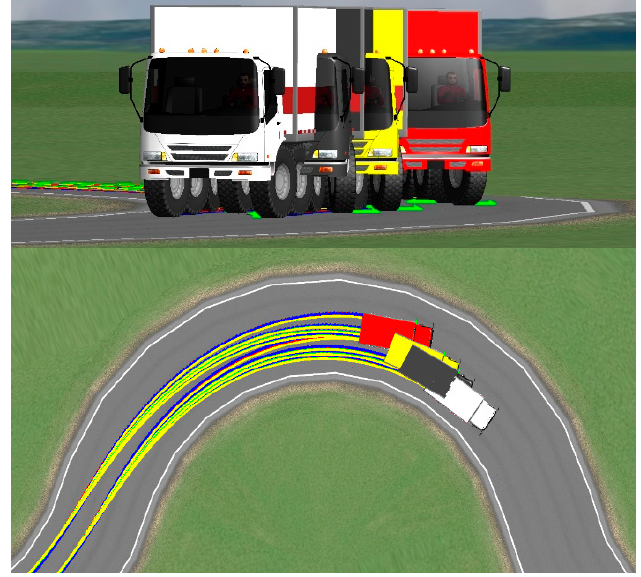
Figure 8. Animation of the trajectories of different vehicles.